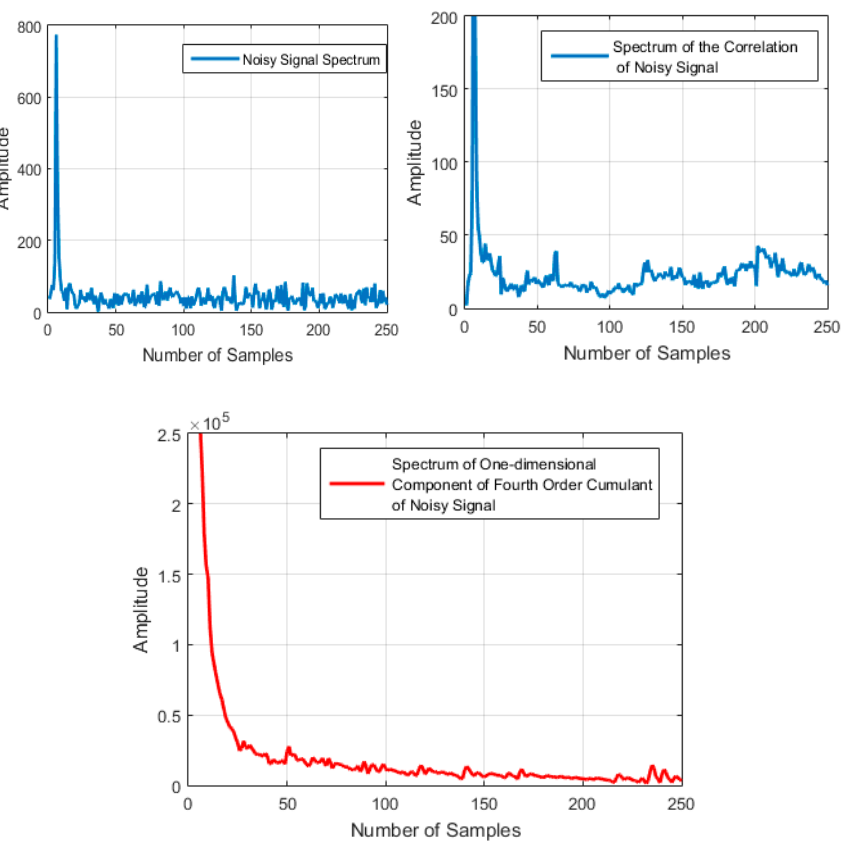
Figure 2. Illustrative example of the Fourier Transform spectrums of the noisy signal (upper-left panel), its correlation function (upper-right panel), and the one-dimensional component of the fourth-order cumulant (lower panel).